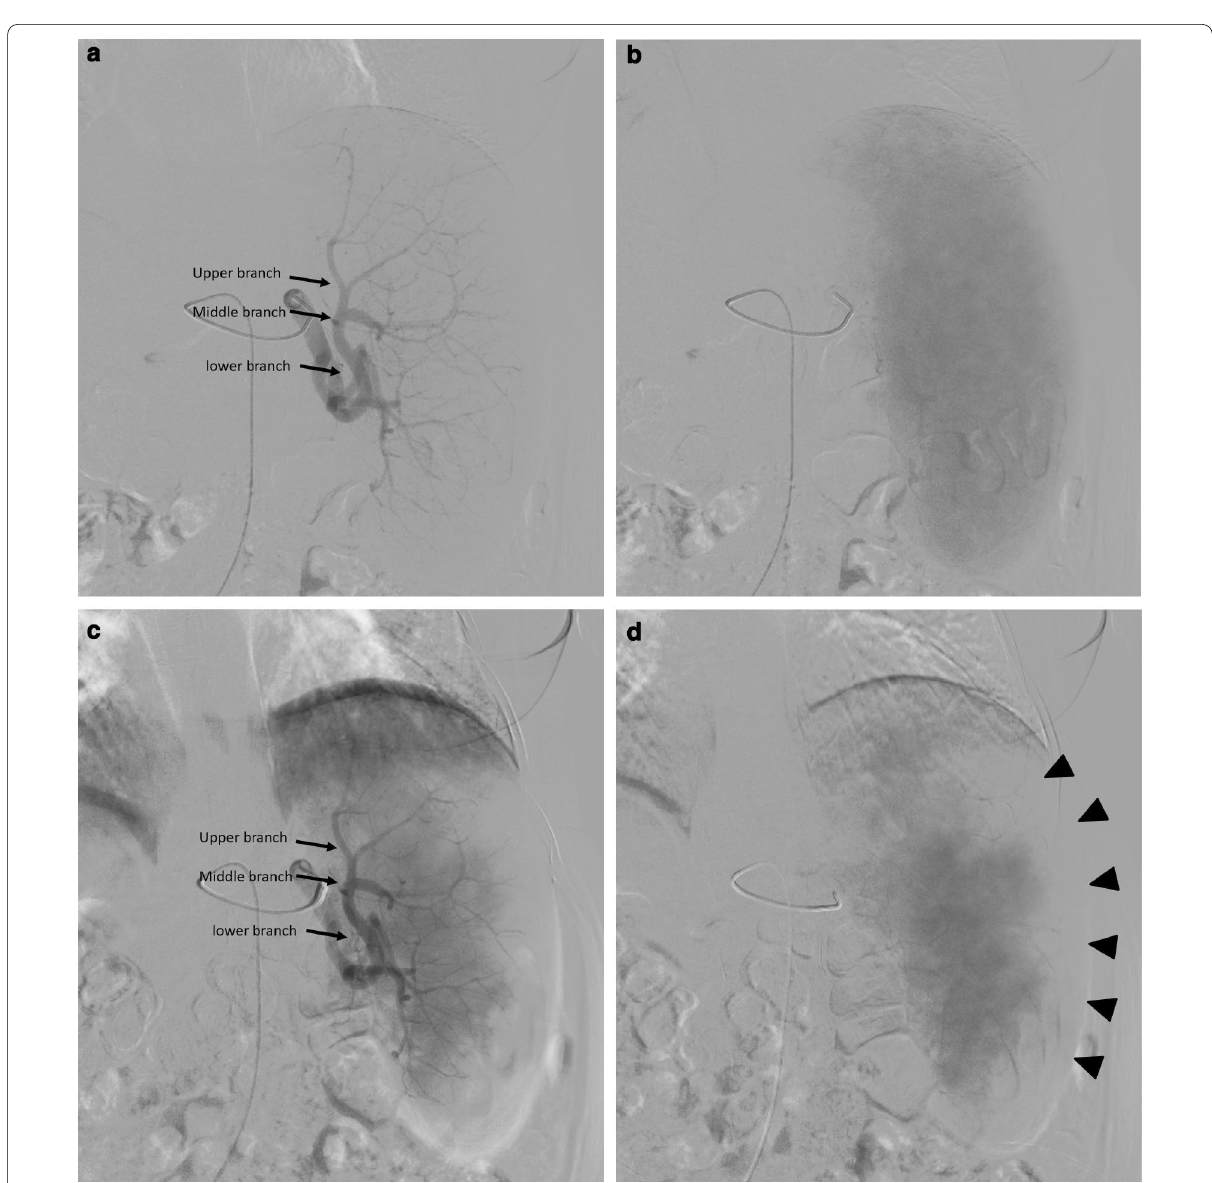
Fig. 2 A 54‑year‑old male patient with cirrhotic hypersplenism due to HCV underwent PSE using embospheres 700–900 µ and using a 5F Cobra catheter. a Digital subtraction angiography in the arterial phase before embolization shows the splenic artery branches; upper, middle, and lower (arrows). b Digital subtraction angiography in the delayed phase before PSE shows the splenic parenchymal blush. c Digital subtraction angiography in the arterial phase after PSE shows the splenic artery branches; upper, middle, and lower (arrows). d Digital subtraction angiography in the delayed phase after PSE shows a decrease in the splenic parenchymal blush by approximately 60%